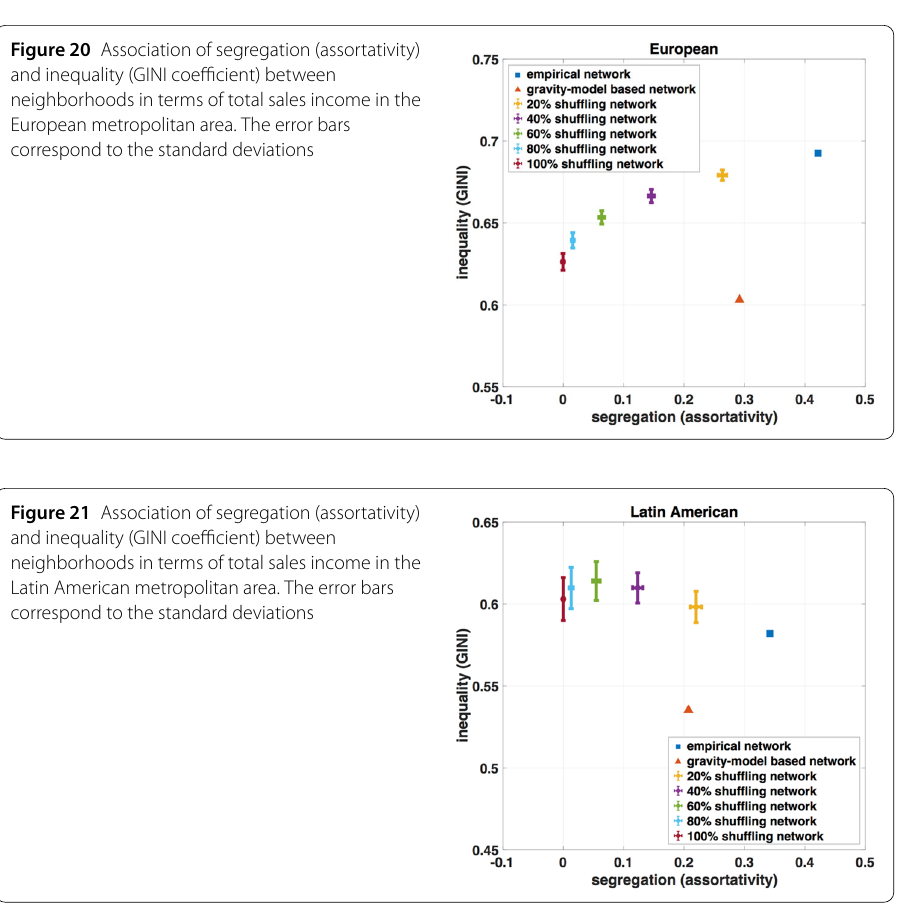
Figure 20 Association of segregation (assortativity) and inequality (GINI coefficient) between neighborhoods in terms of total sales income in the European metropolitan area. The error bars correspond to the standard deviations